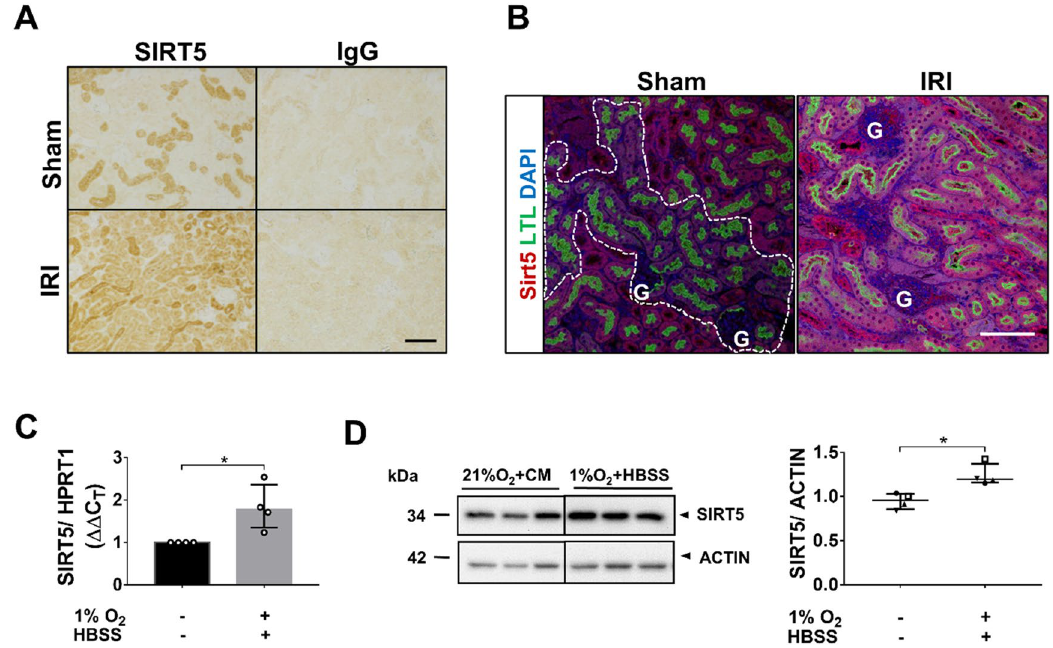
Figure 1. SIRT5 expression increases after ischemia in PTECs in vivo and in vitro. ( A , B ) Male C57BL/6J mice underwent either right uninephrectomy followed by clamping of the left renal pedicle for 30 min (IRI group; bilateral IRI) or sham surgery. Tissues were harvested 48 h post-surgery. ( A ) IHC analysis. Formalin-fixed, paraffin-embedded (FFPE) kidneys (sham and IRI) were screened for SIRT5. Rabbit IgG at an equivalent concentration served as a control. ( B ) Immunofluorescence analysis. Murine FFPE kidney sections (sham and IRI) were co-stained for SIRT5 (red) and LTL (green), a marker of PTECs. 4 ′ ,6-diamidino-2-phenylindole (DAPI) (blue) was used to visualize nuclei. Dashed lines in the sham-surgery group define low SIRT5 expression in PTs. G: Glomeruli. Scale bars: 100 µm. n = 3–5 mice/group. ( C , D ) hPTECs were exposed to control conditions (21%O 2 + CM) or OND (1%O 2 + HBSS). ( C ) Bar graph showing SIRT5 mRNA expression. ( D ) Representative WBs and scatter plot of densitometric analysis showing SIRT5 protein levels. Whole WB shown in supplementary file (Supplementary Fig. S7a). Data are from four independent experiments with n = 3 replicates/ group. mRNA levels were normalized to HPRT1. SIRT5 protein levels were normalized to actin. ImageJ was used for densitometry. To determine statistical significance of mRNA and protein data, a Mann–Whitney test was carried out. Data are median ± IQR. *p <